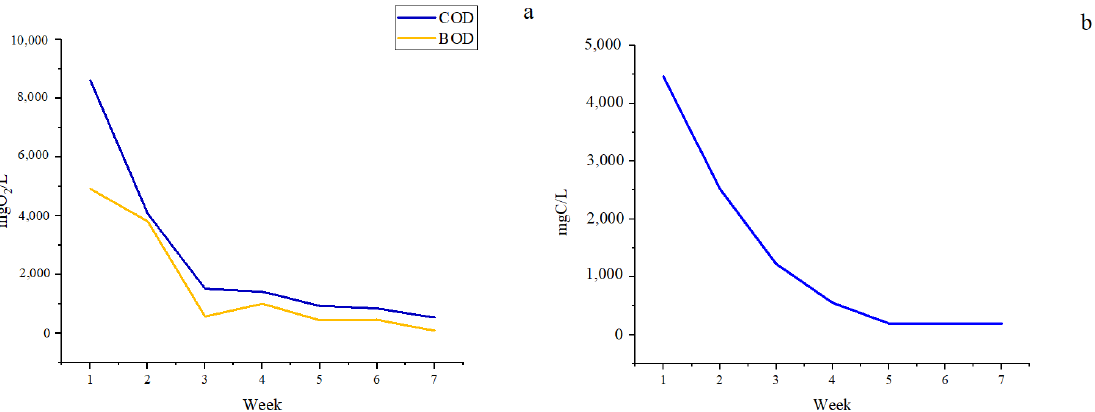
Figure 6. Changes in COD, BOD ( a ), and TOC ( b ) concentration during microalgae wastewater treatment.